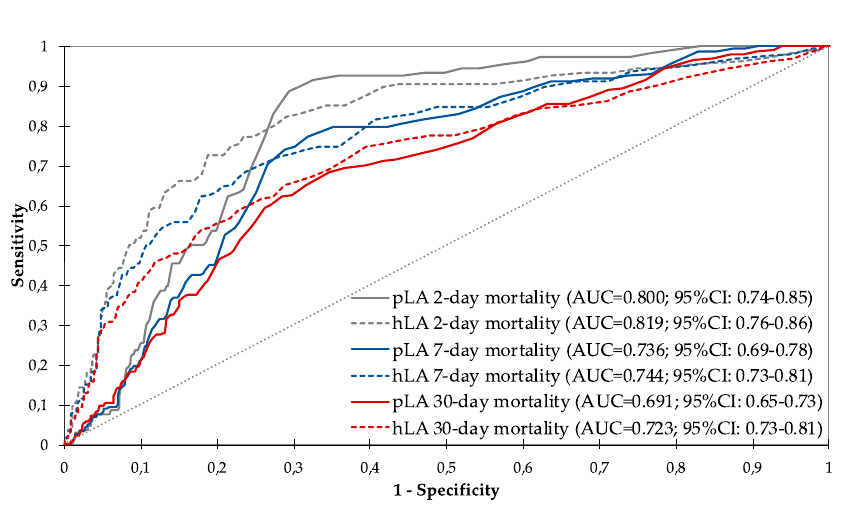
Figure 2. Diagnostic performance curves and areas under the curve with 95% confidence intervals for pLA and hLA for 2, 7 and 30 day mortality (in all cases p < 0.001). pLA: prehospital lactate; hLA: hospital lactate; AUC: area under the curve; CI: confidence interval.